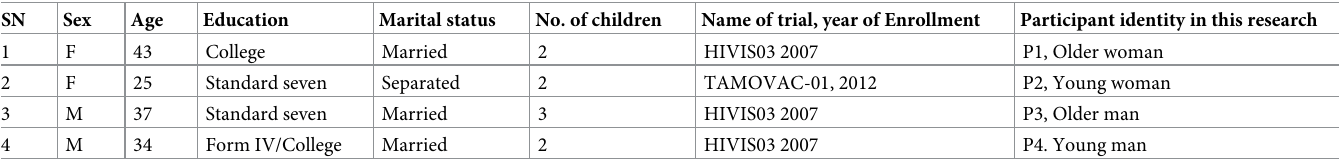
Table 1. Socio-demographic